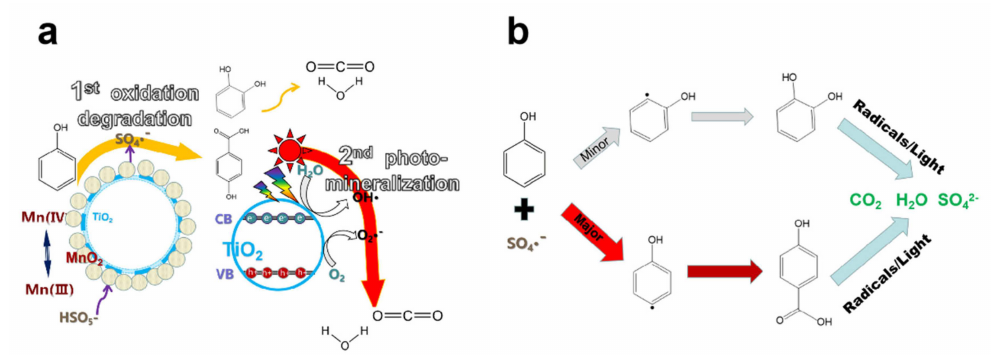
Figure 9. Proposed mechanism ( a ) and pathway ( b ) of phenol degradation for as-synthesized HTM hollow